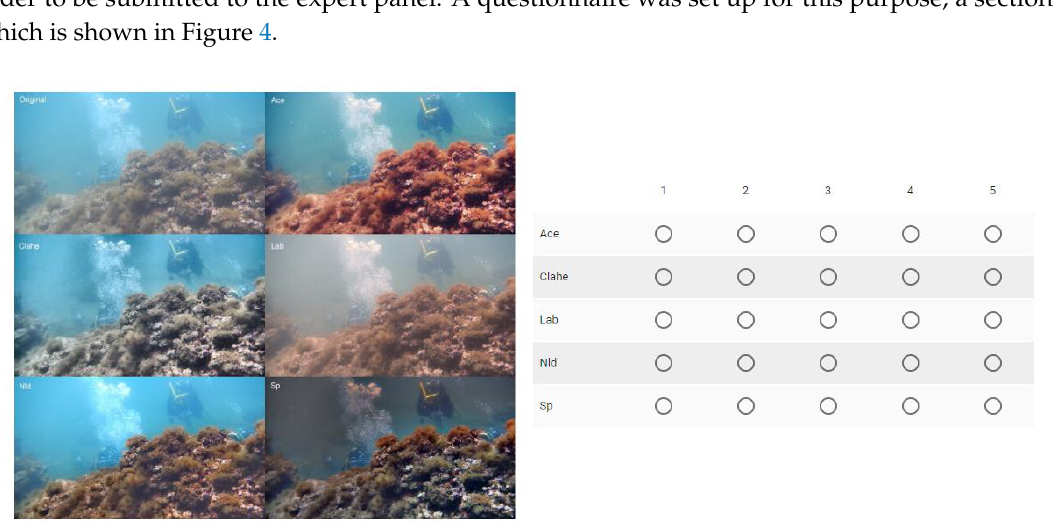
Figure 4 . A sample section of the survey submitted to the expert panel. Figure 4. A sample section of the survey submitted to the expert